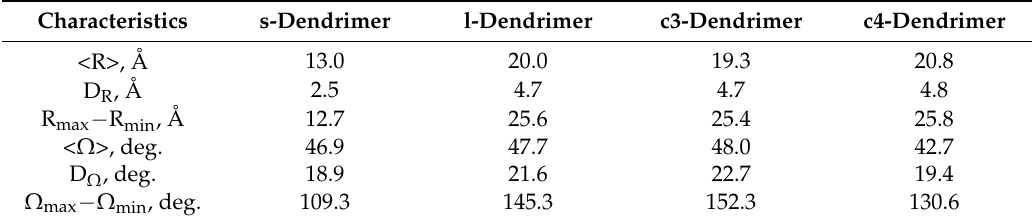
Table 1. Mean values, the root of the dispersion, and the difference between the maximum and minimum values for the end groups of the sixth